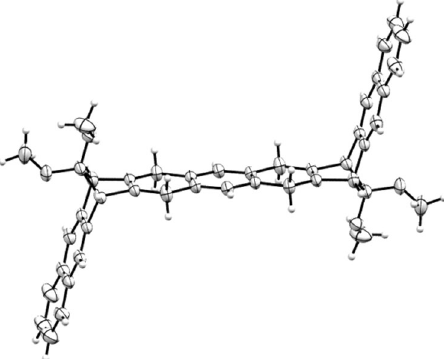
Fig. 4 Ortep representation of isomer 5b. Thermal ellipsoids represent 50% probability